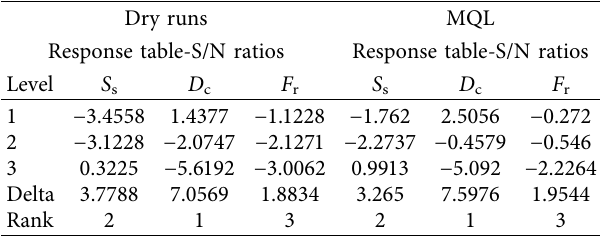
Table 6: Response table for S/N ratios ( R